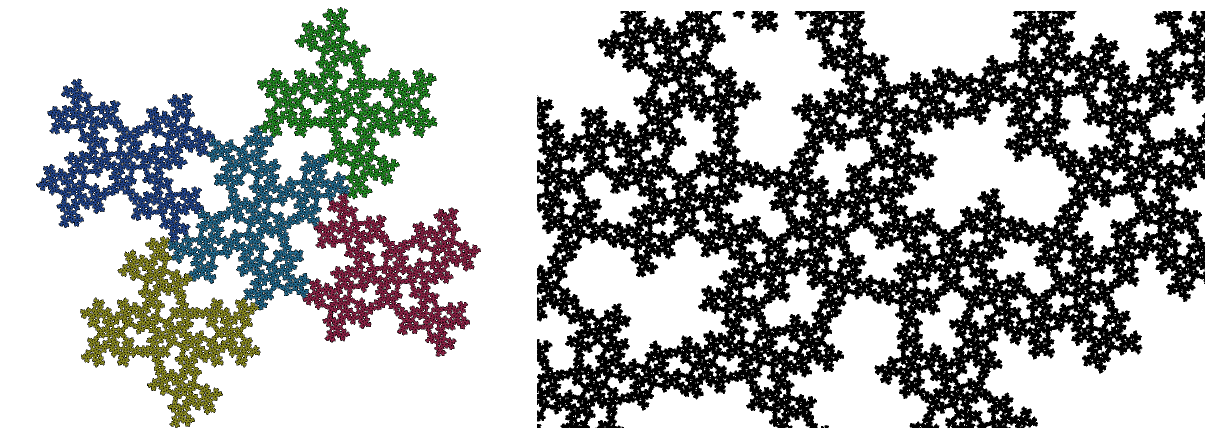
Figure 10. One of the simplest carpets for a = 1/2, which corresponds to Q (